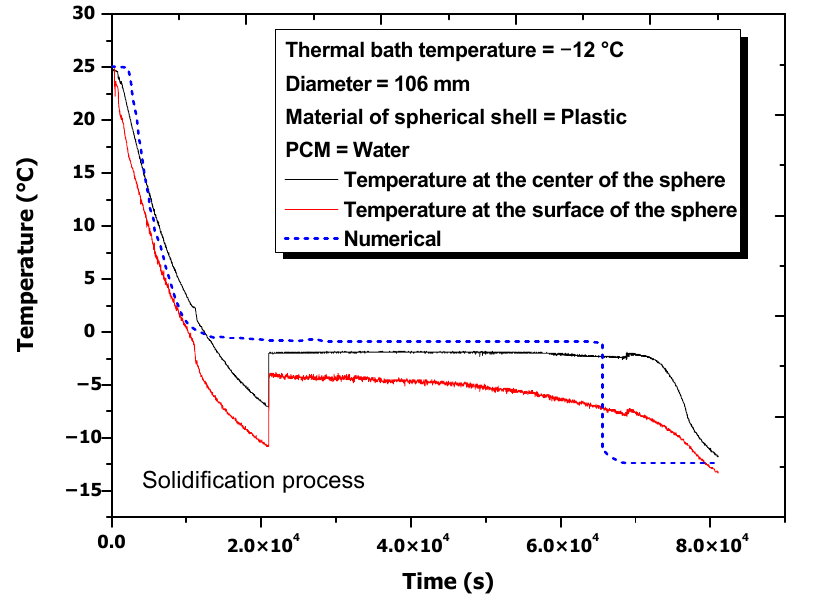
Figure 6. Numerical and experimental temperature change in the solidification process of the 106 mm diameter plastic spherical capsule.